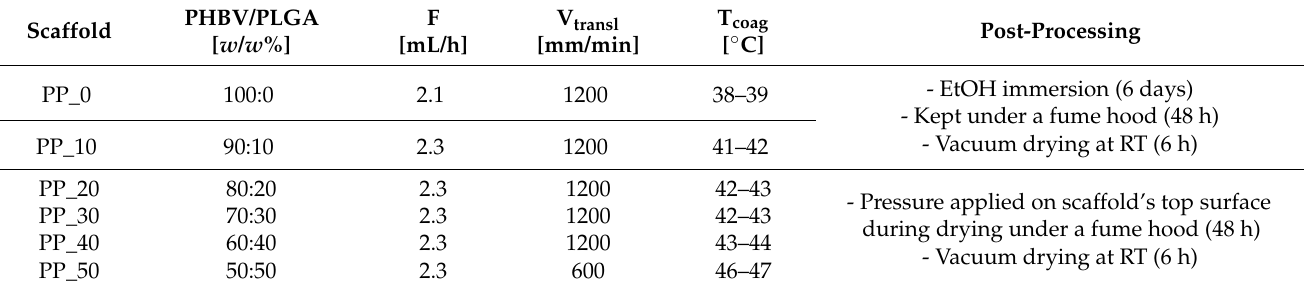
Table 1. Optimized CAWS processing parameters for scaffolds with different PHBV/PLGA ratios.